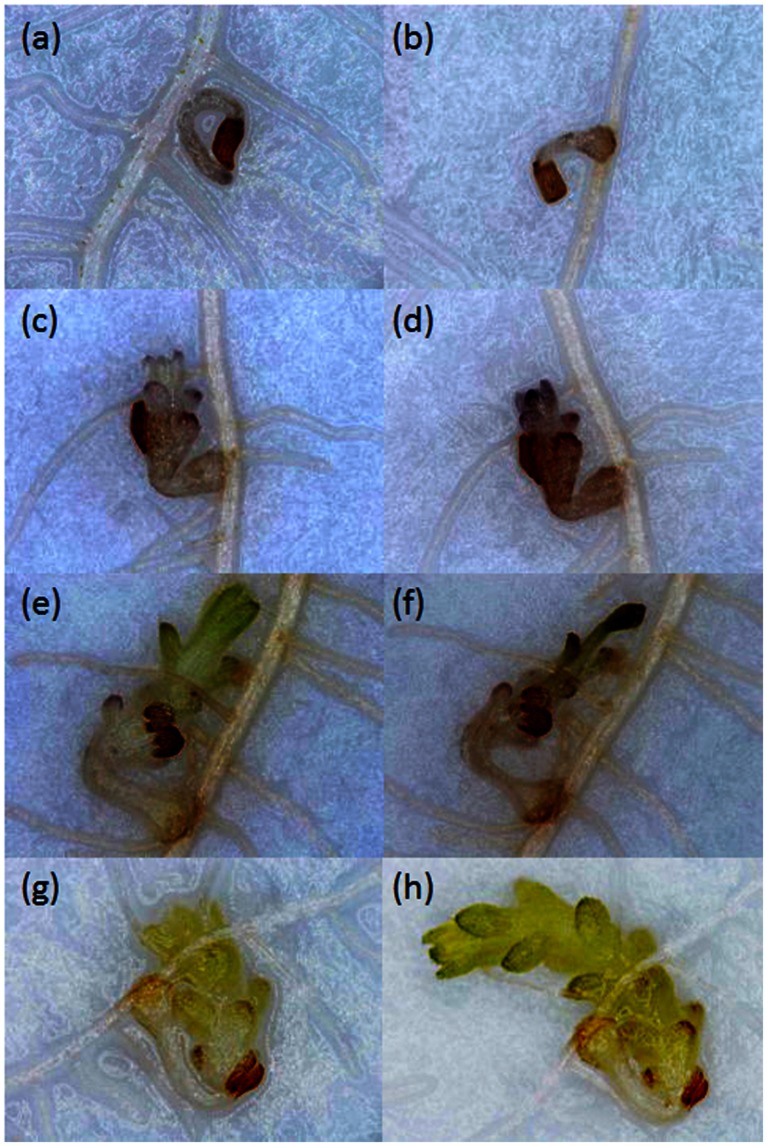
Growth of Striga hermonthica seedlings inoculated onto rice roots in a rhizotron under 100× magnification.
(a) A seedling that failed to attach to the host root at 14 DAI. (b) A seedling that attached to the root but showed no shoot emergence at 21 DAI, or no shoot elongation from (c) 14 DAI to (d) 21 DAI. A seedling that (e) reached the four or more leaf pairs stage before 14 DAI and then (f) died before 21 DAI. A seedling that parasitized successfully with steady healthy shoot growth from (g) 14 DAI to (h) 21 DAI.